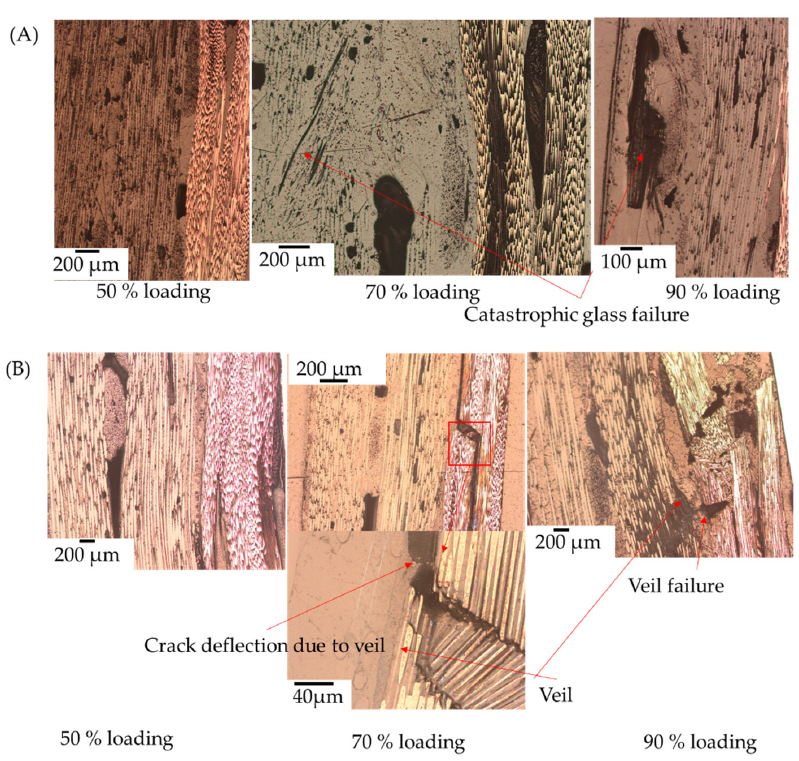
Figure 19. Cyclic loading of HFRP under 50, 70, and 90% loading in three-point bending for ( A ) HF and ( B ) HFT.